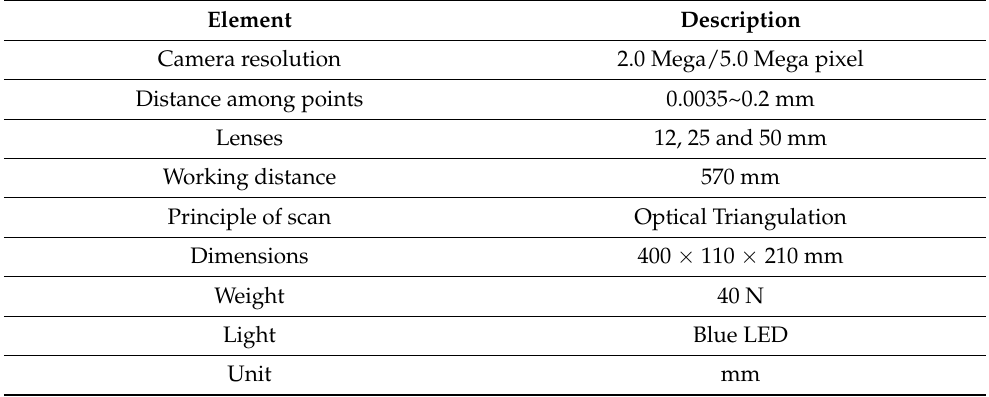
Figure 2. The three tested objects: ( a ) the lab specimen, ( b ) the contemporary violin, and ( c ) the statue of the Gladiator in the Uffizi Gallery. Table 1. Specification of the active 3D device used in the experiments.